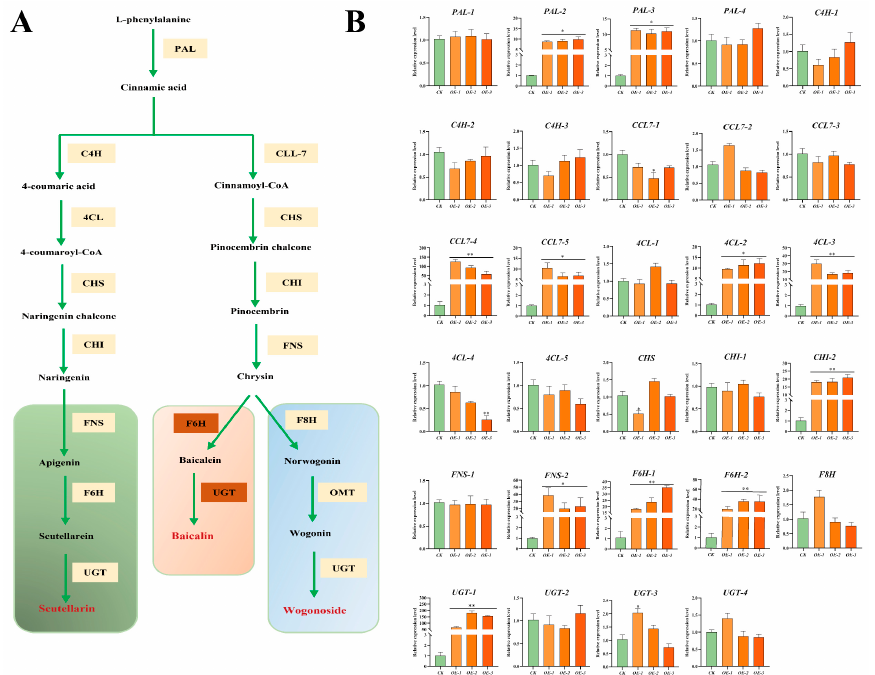
Figure 7. Expression analyses of enzyme genes for the flavonoid biosynthesis pathway in SbMYB12 overexpressed transgenic hairy roots. ( A ) Proposed biosynthetic pathway for flavonoids in S. baicalensis . ( B ) Flavonoid biosynthesis pathway gene expression analysis in S bMYB12 overexpressed strain. Significant differences between the OE lines and the CK were identified (depicted by * p < 0.05, ** p < 0.01) via Student’s t -test.